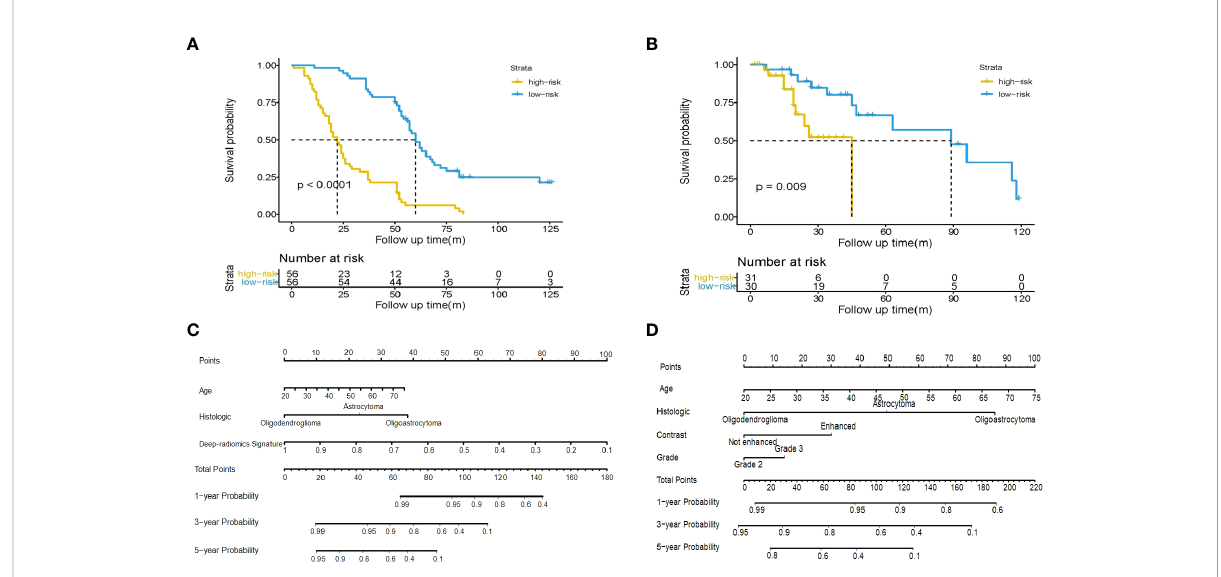
FIGURE 3 Kaplan-Meier plot for OS of patients strati fi ed by the median value of deep-radiomics signature. Signi fi cantly favorable survival in low-risk patients compared to high-risk patients was shown in the training cohort (A) and the validation cohort (B) . Use of the developed integrated nomogram (C) and clinical nomogram (D) estimated the OS for